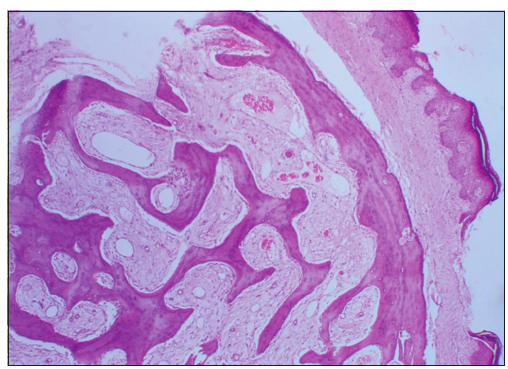
FIGURE 1. Histological section of bony tissue consisted of mature trabecular bones covered by epidermis (hematoxylin and eosin stain,